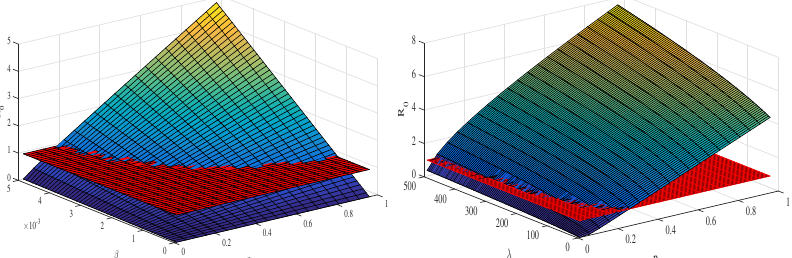
Figure 5. The plots depict the sensitivity analysis of the threshold quantity ( R 0 ) and its relative impact as various epidemic parameters vary. The left panel depicts how the value of the basic reproduction number R 0 changes when the disease transmission rate β and the proliferation rate p vary concurrently. The right panel shows how R 0 changes when the disease transmission rate ( β ) and production rate ( λ ) vary at the same time. The values of the parameters are the same as given in Table